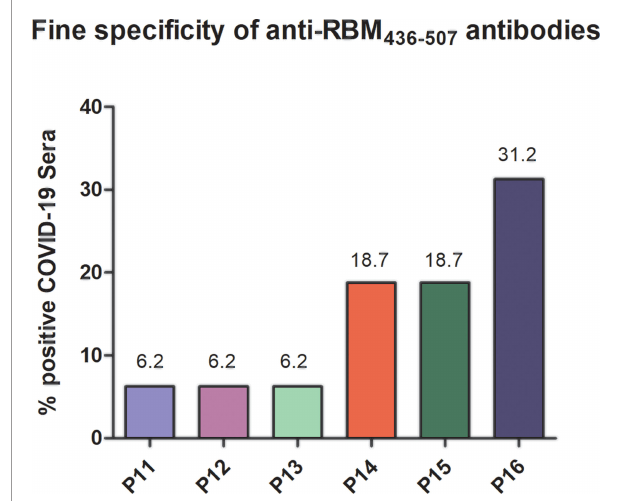
FIGURE 8 | Fine speci fi city of anti-RBM436-507 antibodies in COVID-19 patients. Reactivity of anti-RBM positive COVID-19 sera with 20-mers overlapping peptides (P11-P16) covering the entire RBM 436-507 sequence. Results are shown as percentage of anti-RBM positive sera reacting with the speci fi c